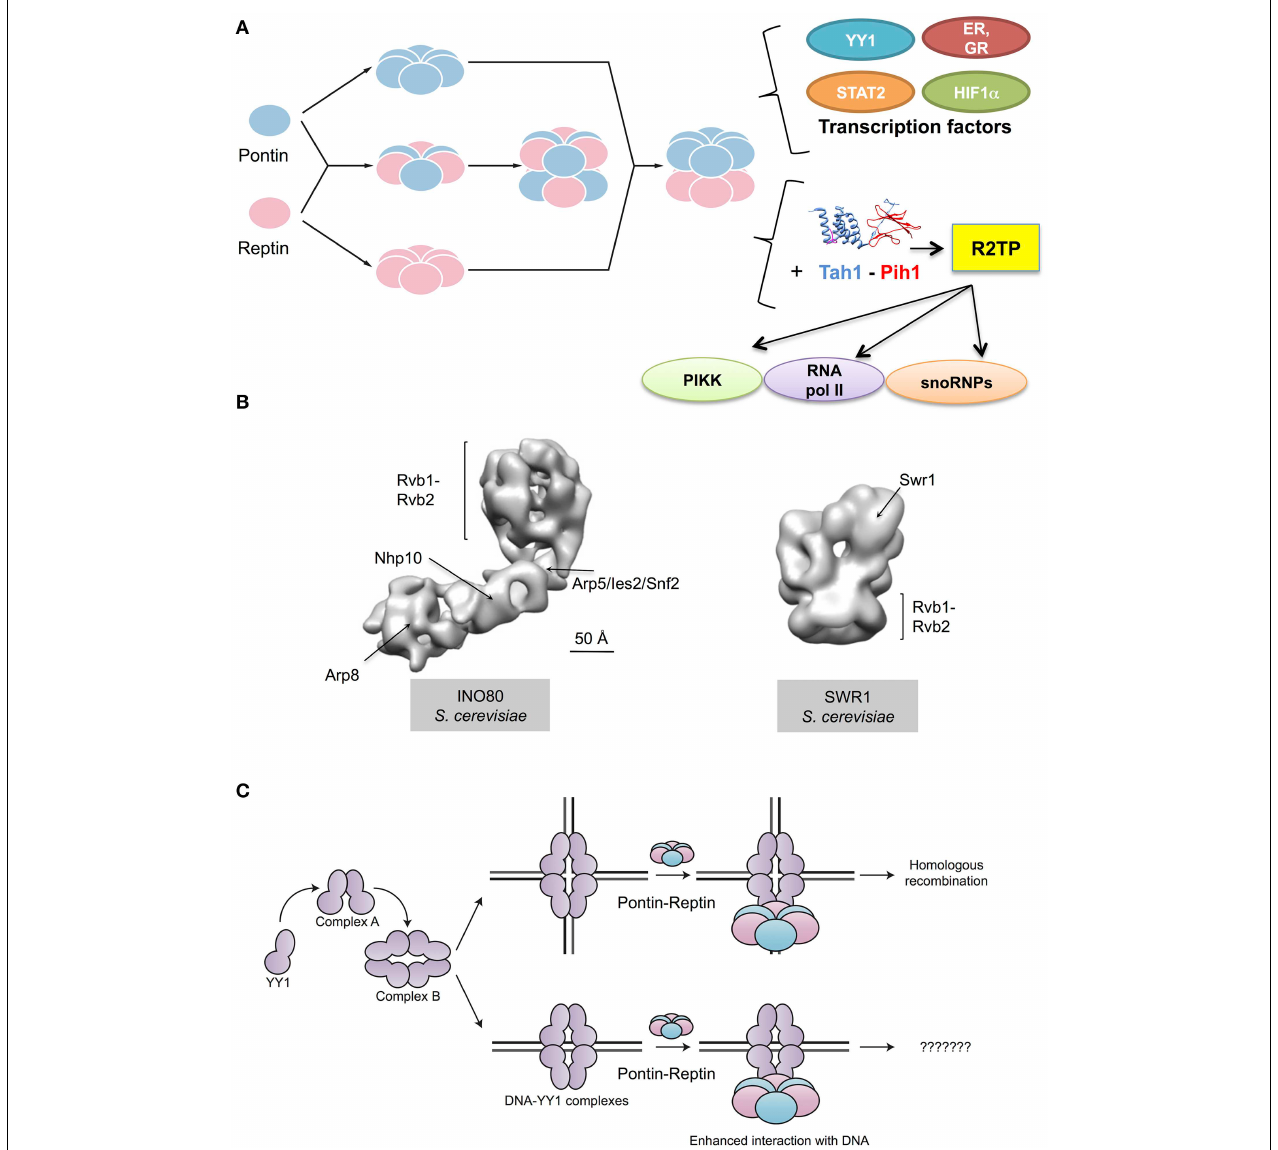
complex and are integral components of this complex. An intermediate resolution structure of INO80 has been recently determined using electron microscopy (EMD-2385 and 2386, Tosi et al., 2013). Within this structure of INO80,severalsubunitshavebeenlocalized,including Rvb1andRvb2.Pontin and Reptin are also part of the SWR1 complex. An intermediate resolution structure of this complex obtained by electron microscopy revealed a ring formed by Rvb1 and Rvb2 functioning as scaffold for other subunits in the complex (EMD-5626, Nguyen et al., 2013). (C) Pontin and Reptin interact with oligomeric forms of YY1 transcription factor, which are labeled as complex A and complex B (Lopez-Perrote et al., 2014). The Pontin-Reptin-YY1 complex shows an enhanced affinity for DNA in vitro , but the relevance of this in the cell is unknown. The Pontin-Reptin-YY1 complex appears to participate in DNA repair by Homologous recombination ( Lopez-Perrote et al.,